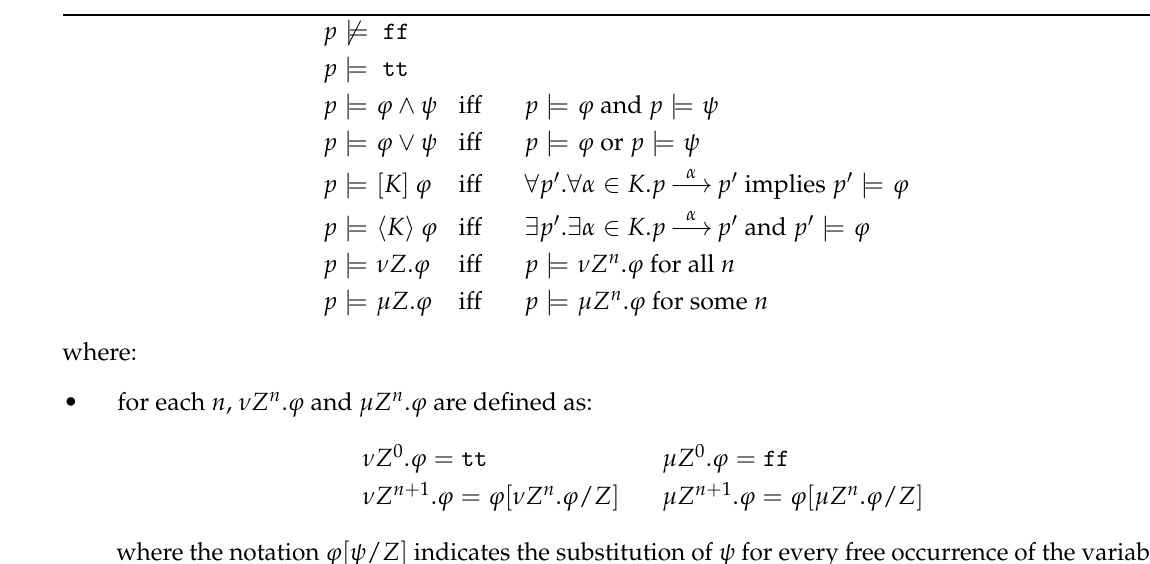
Table 1. Satisfaction of a closed formula by a